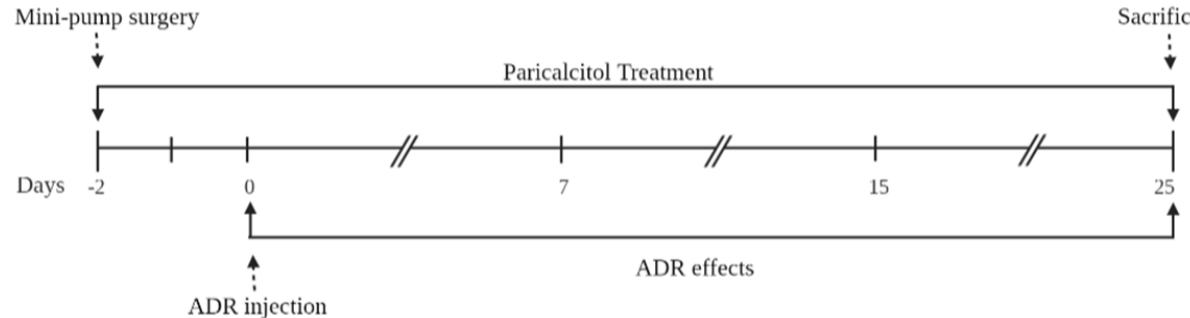
Figure 1. The schematic representation of study design. Male Sprague-Dawley rats underwent mini osmotic pump implanted surgery paricalcitol content two days before ADR administration and continued throughout the observation for 27 days. The animals were divided into 4 experimental groups: Control ( n = 6): rats that received the vehicle; paricalcitol ( n = 6): rats that received paricalcitol and i.v. of the vehicle; ADR ( n = 7): rats that received i.v. of adriamycin, and ADR + paricalcitol (n = 7): rats that received paricalcitol and i.v. of the adriamycin.